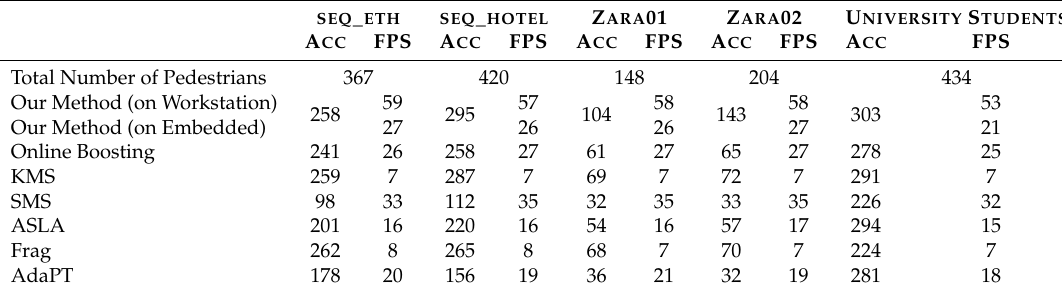
Table 4. Accuracy (in terms of pedestrians tracked in the video sequence) and speed (in terms of frames per second) of the following online algorithms: Our Method compared to Online Boosting